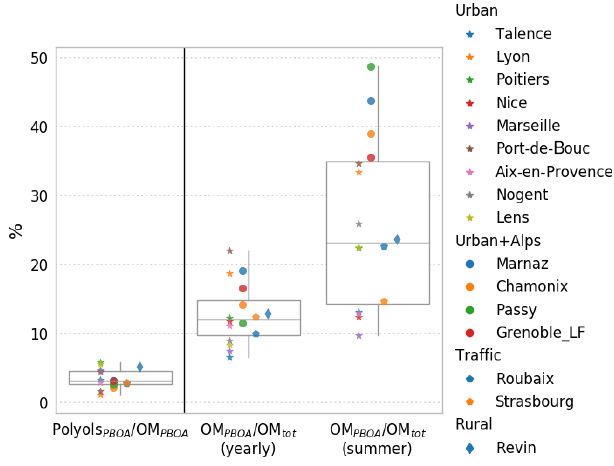
Figure 9. Mass contribution of polyols to OM in the PBOA factor, and relative contributions of the OM PBOA factor to the total OM in PM for the 16 studied sites where the PMF model was run, over the year and summertime only. Stars and circles refer to urban sites without and with Alpine valley influence, respectively. Pentagons correspond to traffic sites and diamonds to rural